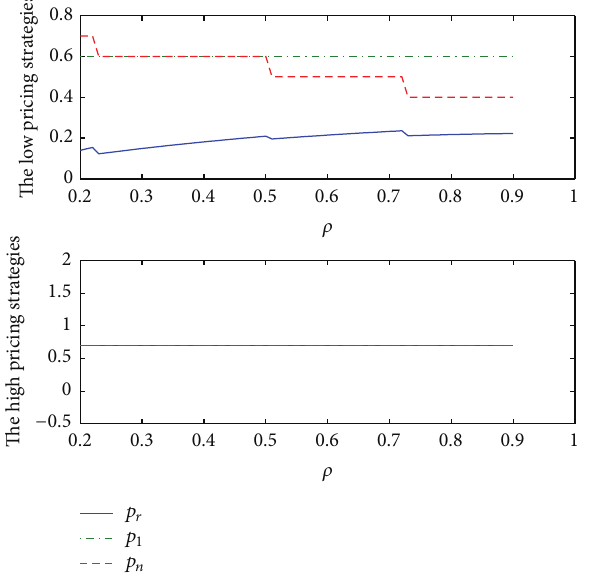
Figure 2: The pricing strategy according to the low disassemblabil-